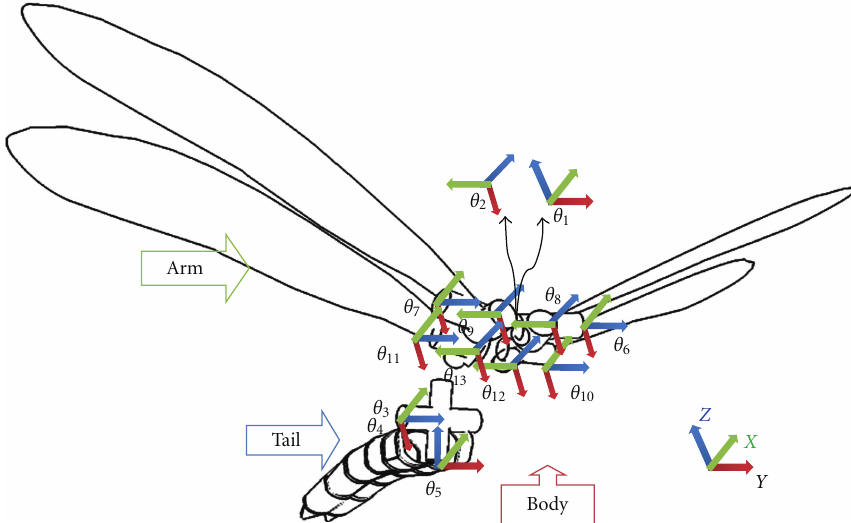
Figure 2: Kinematic structure of the system.